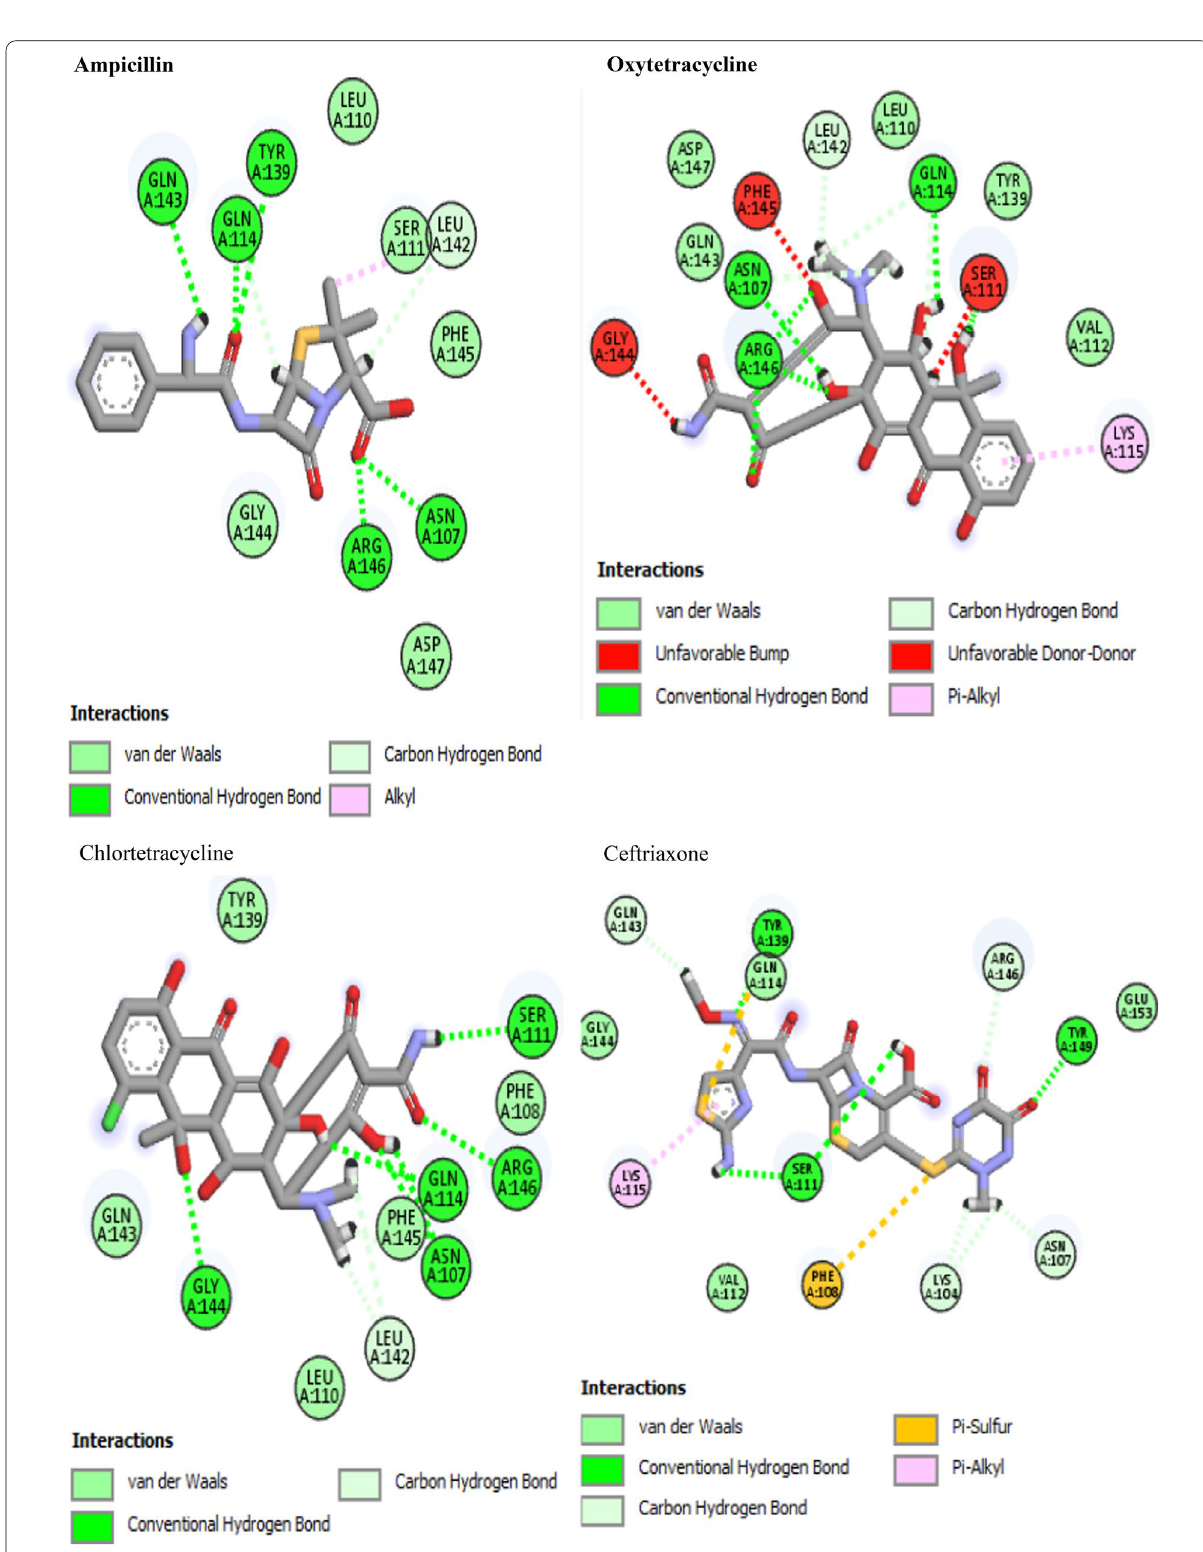
Fig. 3 2D diagram of reference drugs and the crystal structure of IncA soluble domain